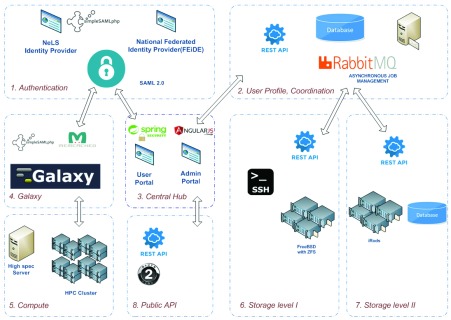
NeLS Architecture.